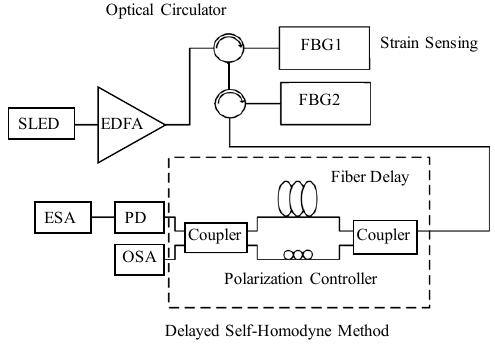
Figure 1. The fiber strain testing setup for two reflective FBG spectral linewidth characterization.